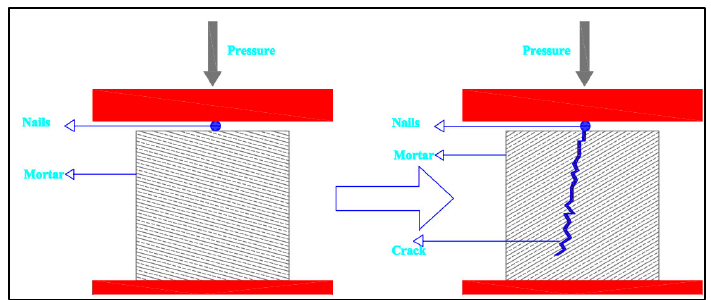
Figure 5. Mortar sample crack formation (schematic diagram).